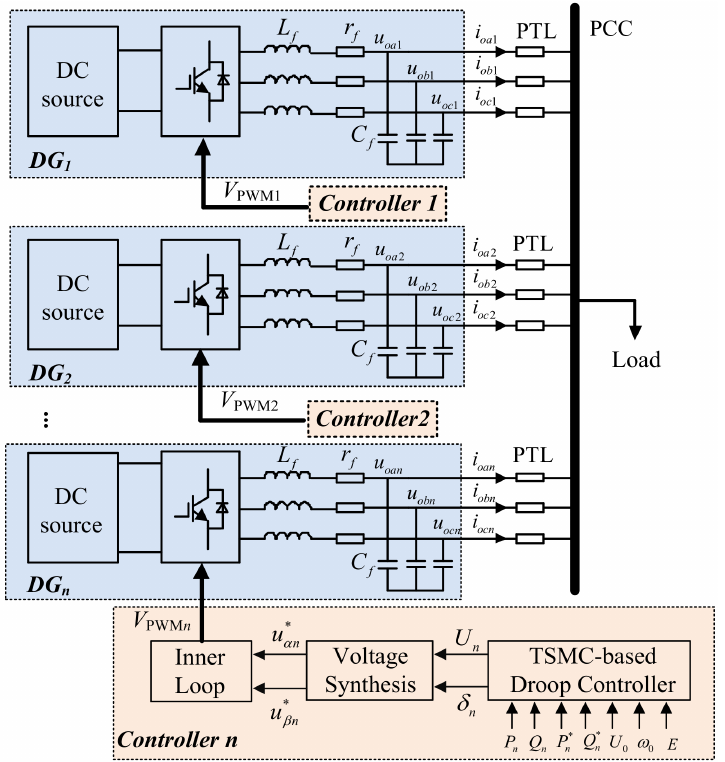
Figure 1. Simplified structure of islanded